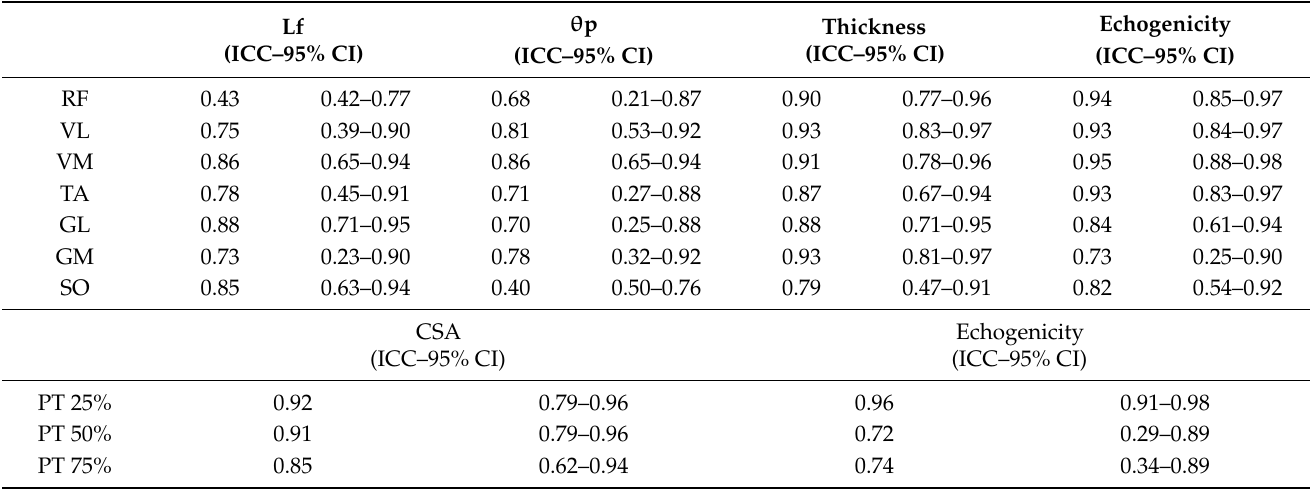
Table 3. Inter-rater reliability and 95% CI of the muscle and tendon architecture and echogenicity obtained from the sample ( n = 20) of Raters 1 and